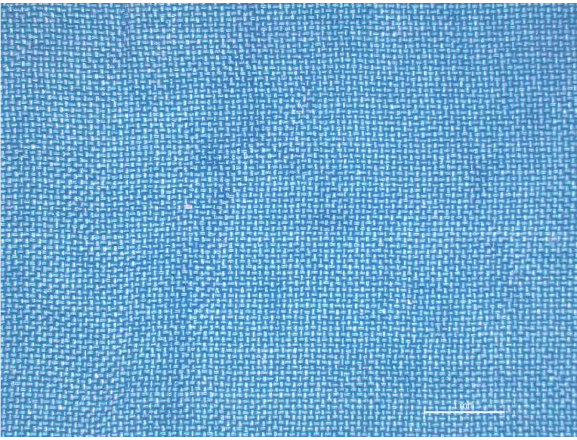
Figure 4. Creases on polyamide 6 (PA6) fabric dyed with dye concentration of 0.2% on mass fabric (o.m.f.).